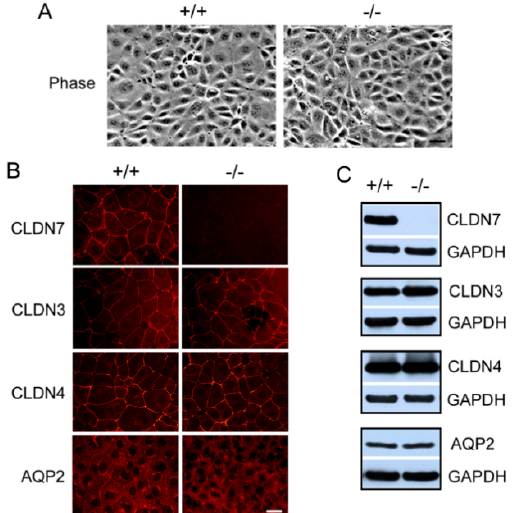
Figure 1. Characterization of immortalized mouse collecting duct (CD) cell lines. ( A ) Phase images of CLDN7 +/+ ( +/+ ) and CLDN7 − / − ( − / − ) CD cells. CD cells from 4-day old mouse CLDN7 +/+ and CLDN7 − / − kidneys were isolated and purified by Dolichos biflorus lectin-coated Dynabeads. These purified CD cells were immortalized into cell lines using SV40 virus. The stable CD cells were grown on coverslips for 5–7 days before fixation for fluorescent light microcopy. Bar: 30 µ m. ( B ) CLDN7 +/+ and CLDN7 − / − CD cells were immunostained with antibodies against CLDN7, CLDN3, CLDN4, and AQP2 and detected by Cy3-conjugated anti-rabbit secondary antibody. CLDN7 +/+ CD cells showed a strong anti-CLDN7 immunostaining and this signal was completely absent in CLDN7 − / − CD cells. Both CLDN3 and CLDN4 have similar staining patterns in CLDN7 +/+ and CLDN7 − / − CD cells. AQP2 is a marker protein for CD principle cells and its membrane staining was much weaker in CLDN7 − / − than in CLDN7 +/+ CD cells. Bar: 20 µ m. ( C ) Western blot analysis confirmed the absence of CLDN7 protein in CLDN7 − / − CD cells. CLDN3, CLDN4, and AQP2 expression levels were similar between CLDN7 +/+ and CLDN7 − / − CD cells. GAPDH signal was used as a loading control.